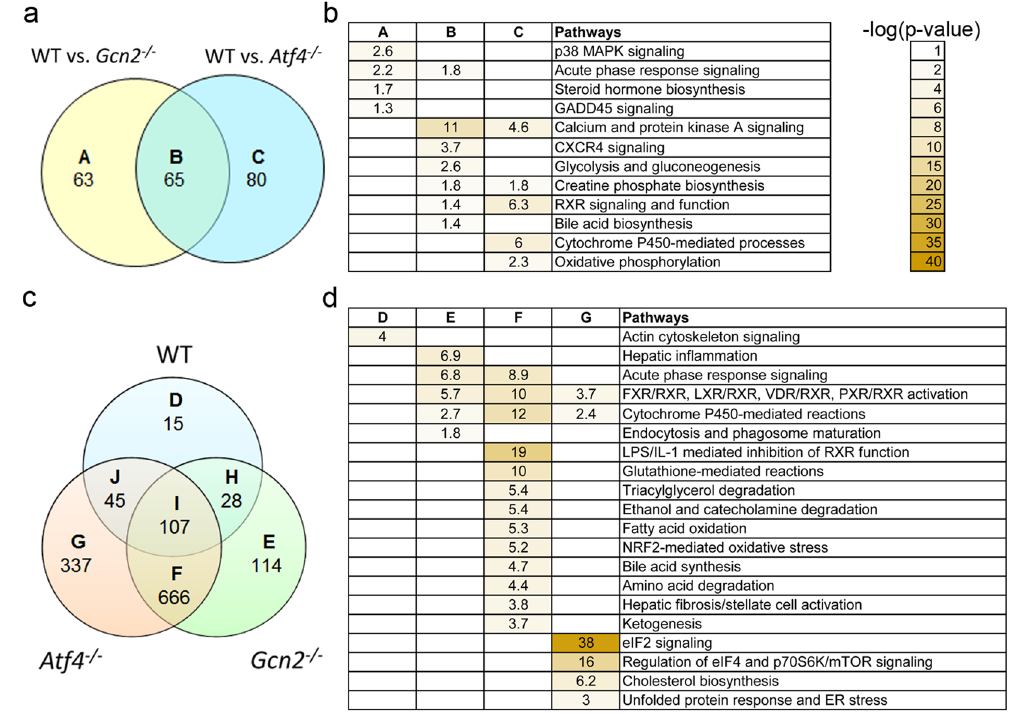
Figure 2. Transcriptional profiling of livers following 8 daily injections of asparaginase (3 IU per gram body weight, ASNase) or phosphate buffered saline excipient (PBS) in wild type mice (WT) or mice deleted for Gcn2 ( Gcn2 − / − ) or Atf4 ( Atf4 − / − ). ( a ) Venn diagram shows the number of hepatic genes altered basally, categorized as unique to Gcn2 − / − [A], unique to Atf4 − / − [C] or common to deletion of either [B]. ( b ) Overview of the top overrepresented canonical pathways based on gene expression changes in panel a. ( c ) Venn diagram shows ASNase alters the transcriptome differently in WT, Gcn2 − / − and Atf4 − / − mice, with gene changes clustered as unique to WT [D], unique to Gcn2 − / − [E]; unique to Atf4 − / − [G]; common to Gcn2 − / − and Atf4 − / − [F]; common to WT and Gcn2 − / − [H]; common to WT and Atf4 − / − [J]; and common to all strains [I]. ( d ) Overview of the top overrepresented canonical pathways based on gene expression changes in panel c. Data represent n = 3 per group. All differentially expressed genes were statistically significant at a false discovery rate (q value) <